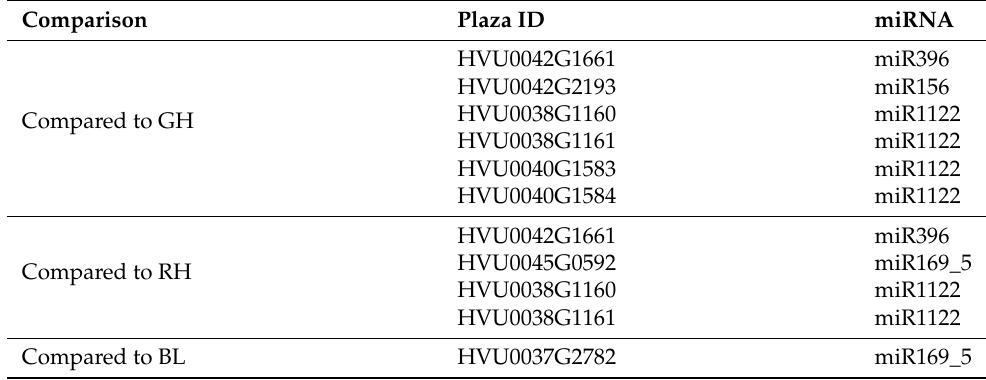
Table 1. Analysis of miRNAs with the potential to induce PTGS which were underexpressed under BH conditions compared to GH, RH, and BL,